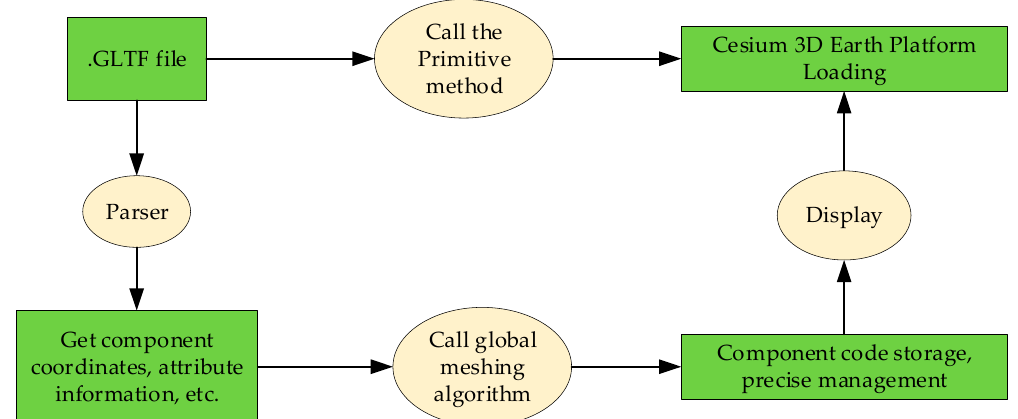
Figure 7. BIM model data loading and processing flow chart.